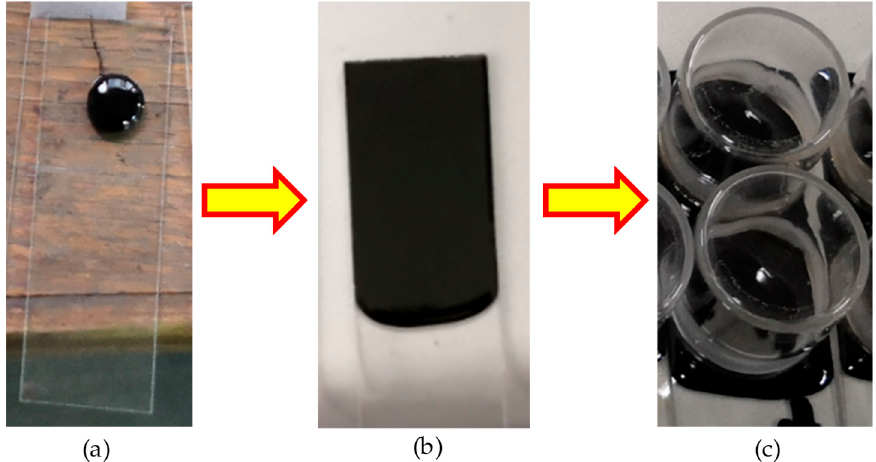
Figure 3. Photograph of the atomic force microscope (AFM) sample preparation process. ( a ) bitumen; ( b ) horizontal treatment; ( c ) Dust-proof treatment.